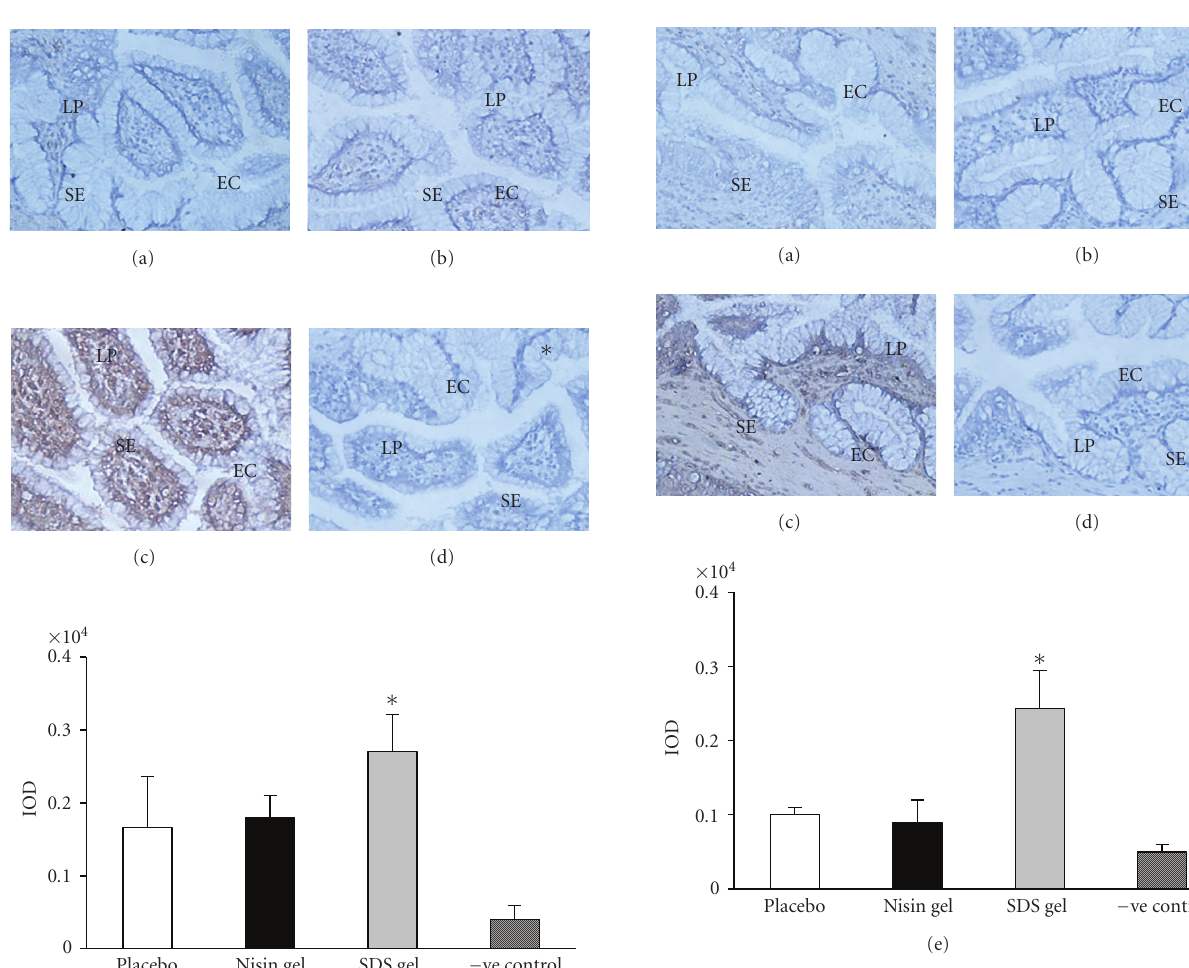
Figure 5: Immunohistochemical localization of IL-6 in the cervi- covaginal tissue after intravaginal application of nisin (15.15mM in 2mL of 1% polycarbophil gel) (b), SDS (56 μ M in 2 mL of 1% polycarbophil gel) (c) and 2mL 1% polycarbophil gel (a) for 14 consecutive days. To rule out the nonspecific binding, sections were incubated in preimmune sera instead of primary antibody and considered as negative control (d). Semiquantitative comparison by measuring integrated optical density (IOD) of immunoreactive IL-6 is shown (e). The IOD in each area was then measured for the brown color immunoprecipitates. Each value is the mean ± SD of six observations obtained from three independent samples. The figure shown is representative pictures from three independent rabbits (Mag X 20). (EC = epithelial cells, SE = squamous epithelium, LP = lamina propria) ( ∗ = value are statistically significant at P < .